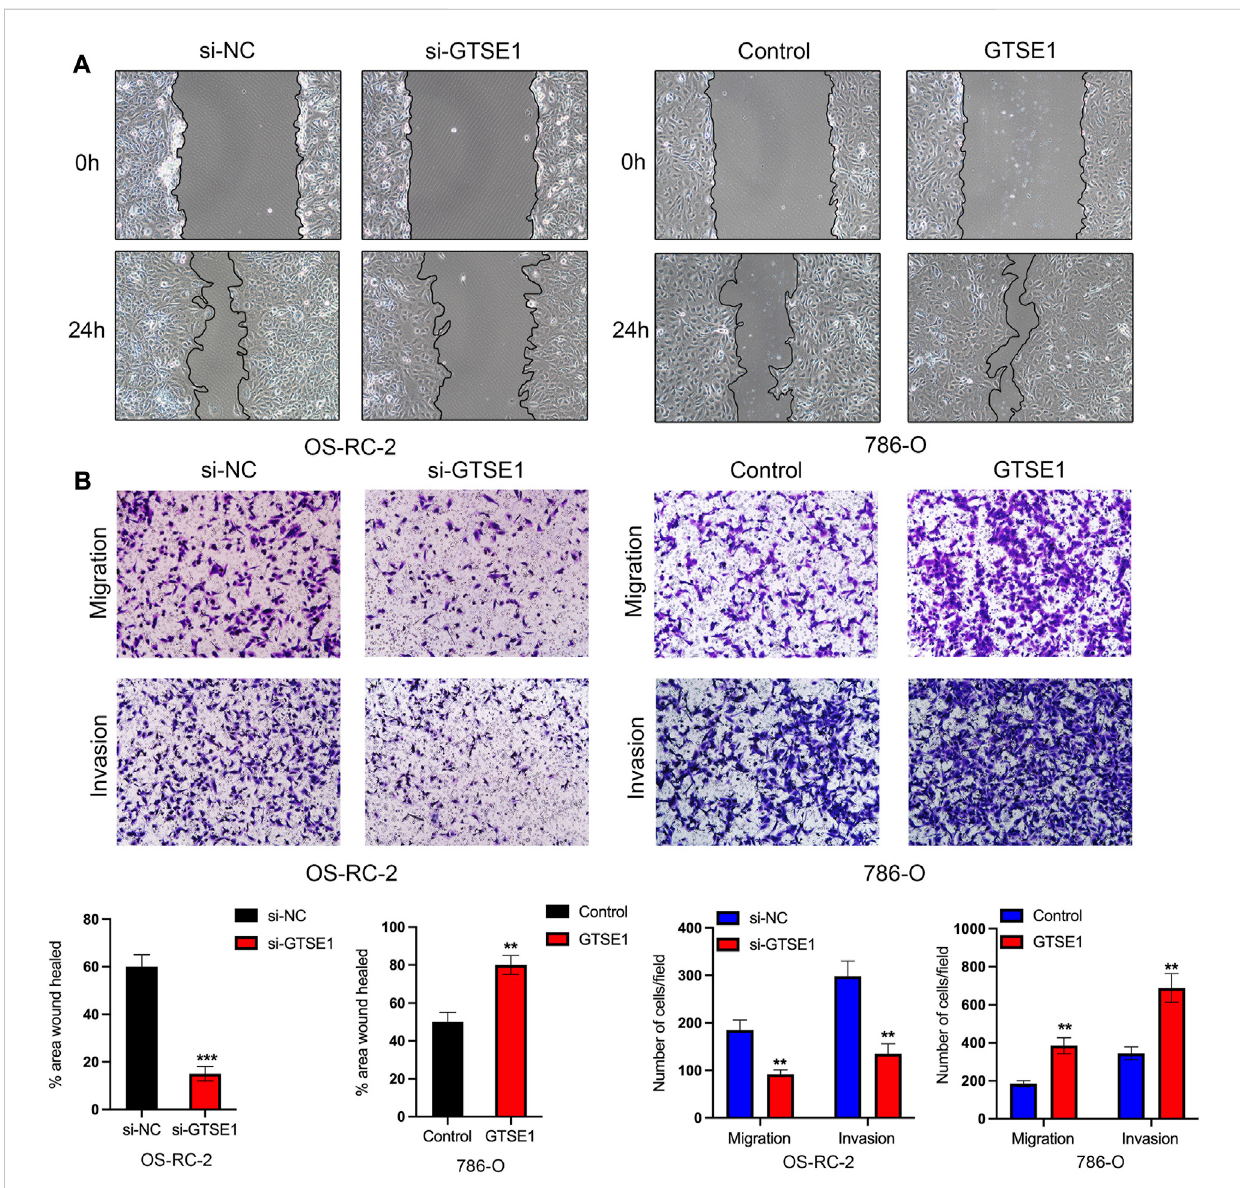
FIGURE 10 Effect of GTSE1 on cell migration and invasiveness in ccRCC (A) Representative images of wound healing in OS-RC-2 and 786-O cells. (B) Cell migration and invasion abilities were detected by transwell assays with or without Matrigel in OS-RC-2 cells with GTSE1 knockdown and in 786-O cells with GTSE1 overexpression. The quantitative analysis is shown below. ** p < 0.01, *** p <